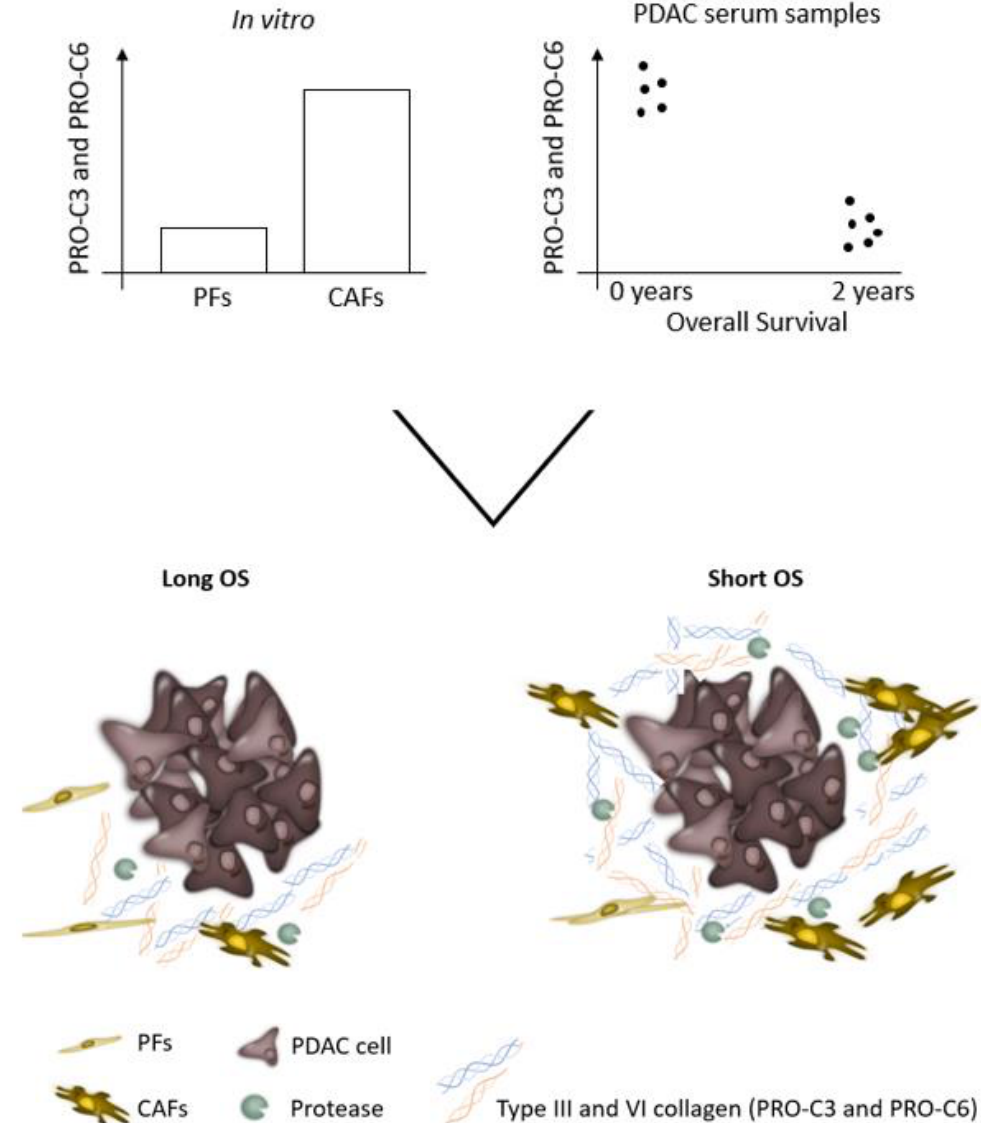
Figure 7. Summary figure. PRO-C3 and PRO-C6 are increased in pancreatic cancer-associated fibrob- lasts (CAFs) compared to pancreatic quiescent fibroblasts (PFs). High levels of PRO-C3 and PRO-C6 are prognostic for short overall survival in patients with pancreatic ductal adenocarcinoma